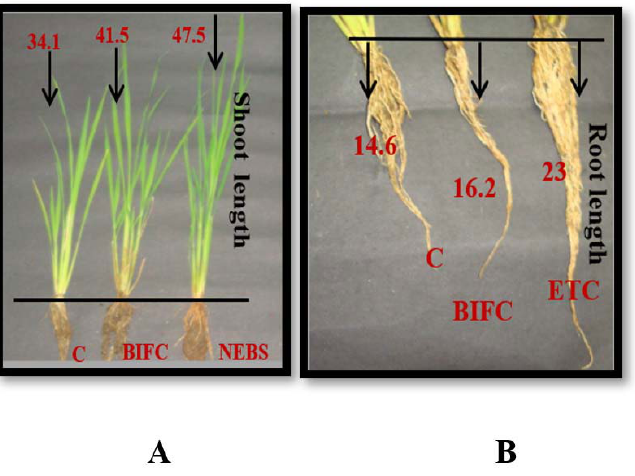
Fig. 2. Growth of rice seedlings after 45 th day of seed sowing. 1 = Control (C) (34.1 cm); 2= Biofertilizer Control (BIFC) (41.5 cm); 3= Non - Enriched Banana peel Single bacterium group (NEBS) (47.5